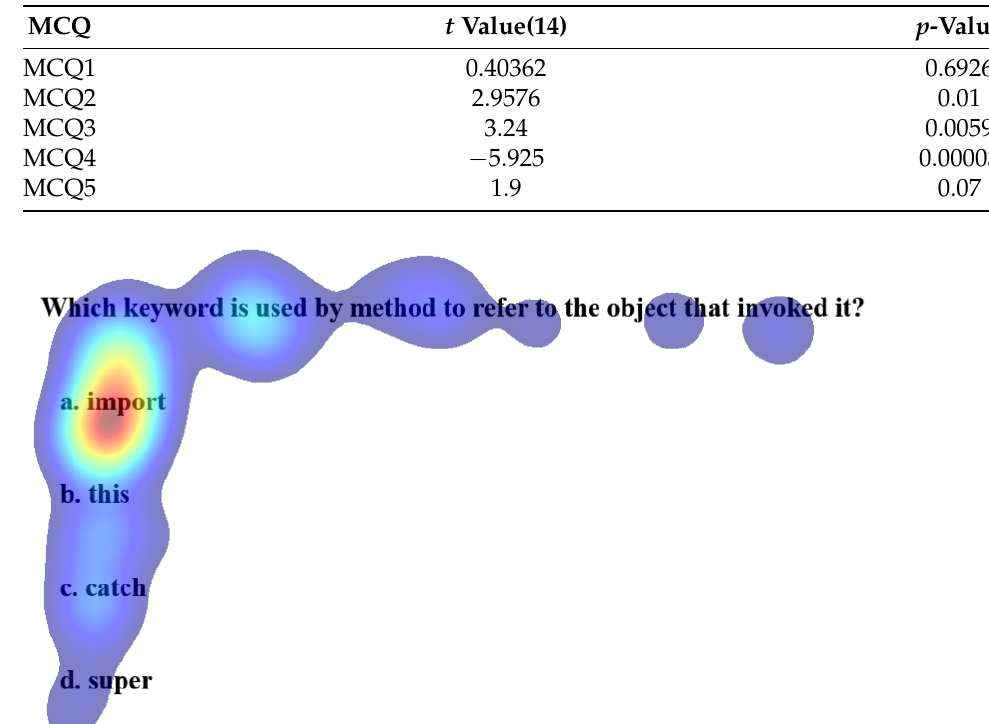
Table 3. Mean and Standard deviation of gazing at correct option and keyword.